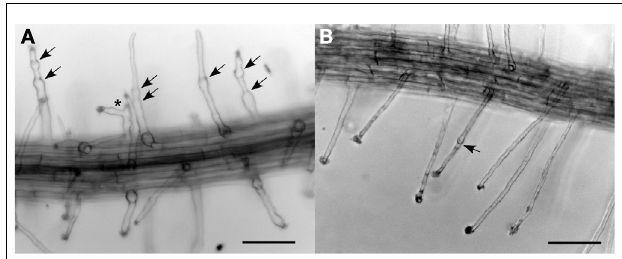
FIGURE 5 |Tip rupture and re-growth of csld2 single mutants (A) and csld2 csld3 dihybrids (B). The arrows indicate the points of tip growth rupture and growth resumption.The asterisk indicates a branched root hair. Bars = 100 μ